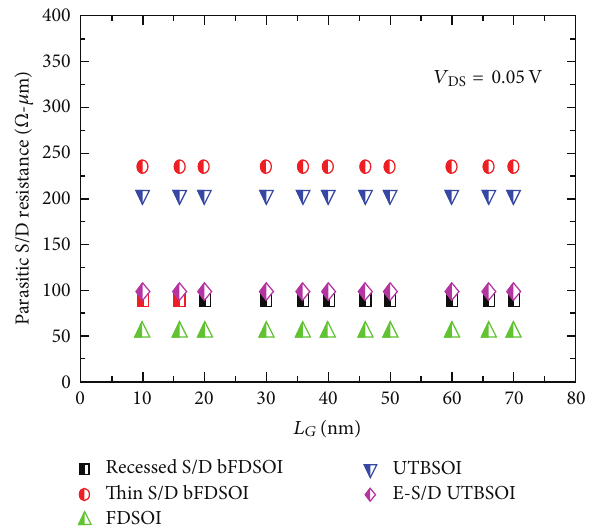
Figure 7: Simulated 𝑅 in different transistors for a low drain bias S / D = 0.05 V) and high gate bias ( 𝑉 = 5.0 V). As shown in the ( 𝑉 DS GS figure, other than the thin S/D bFDSOI and UTSOI devices, devices = 1.0 V). It is because of thick S/D show lower 𝑅 S / D DS